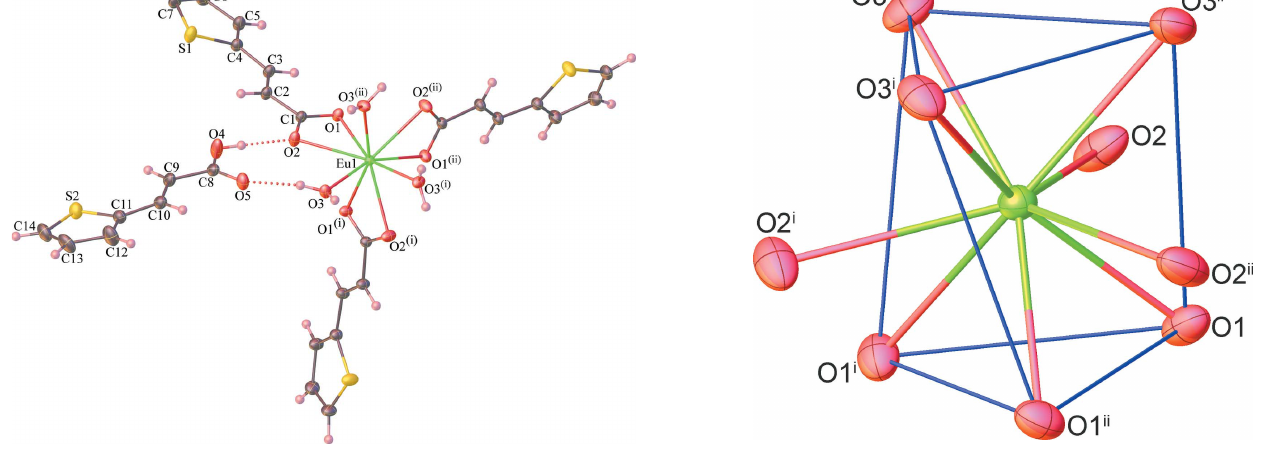
Figure 1 Molecular structure of the title compound 1 . Displacement ellipsoids are drawn at the 30% probability level. All hydrogen atoms were omitted for clarity. Symmetry codes: (i) (cid:3) x + y , (cid:3) x + 1, z ; (ii) (cid:3) y + 1, x (cid:3) y + 1, z